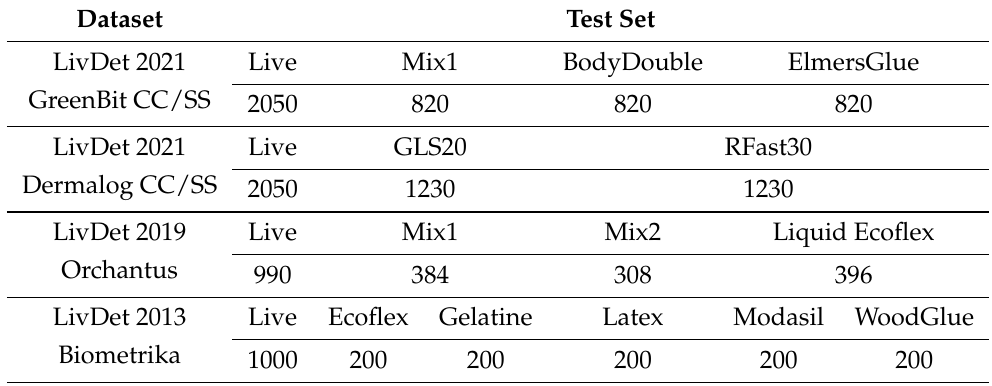
Table 4. Number of samples for each scanner employed in the test phase.